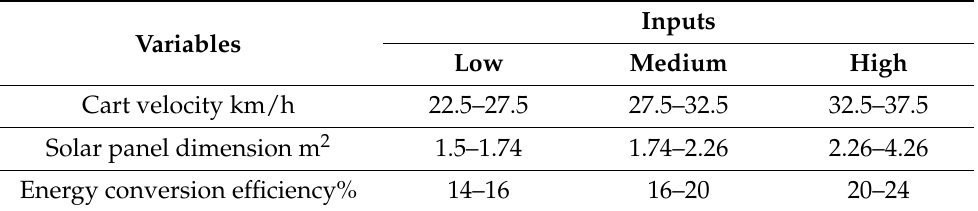
Table 3. Levels and name of inputs (triangular membership function) used and output variables and range